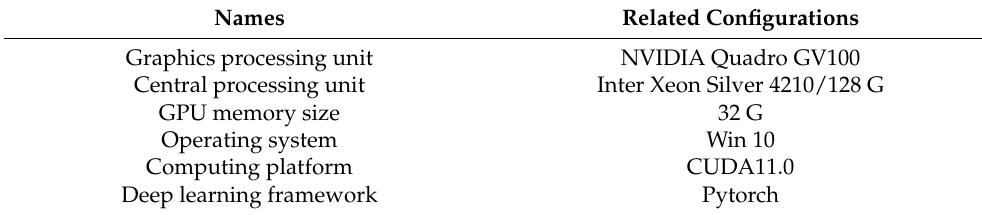
Table 2. Experimental platform configuration.